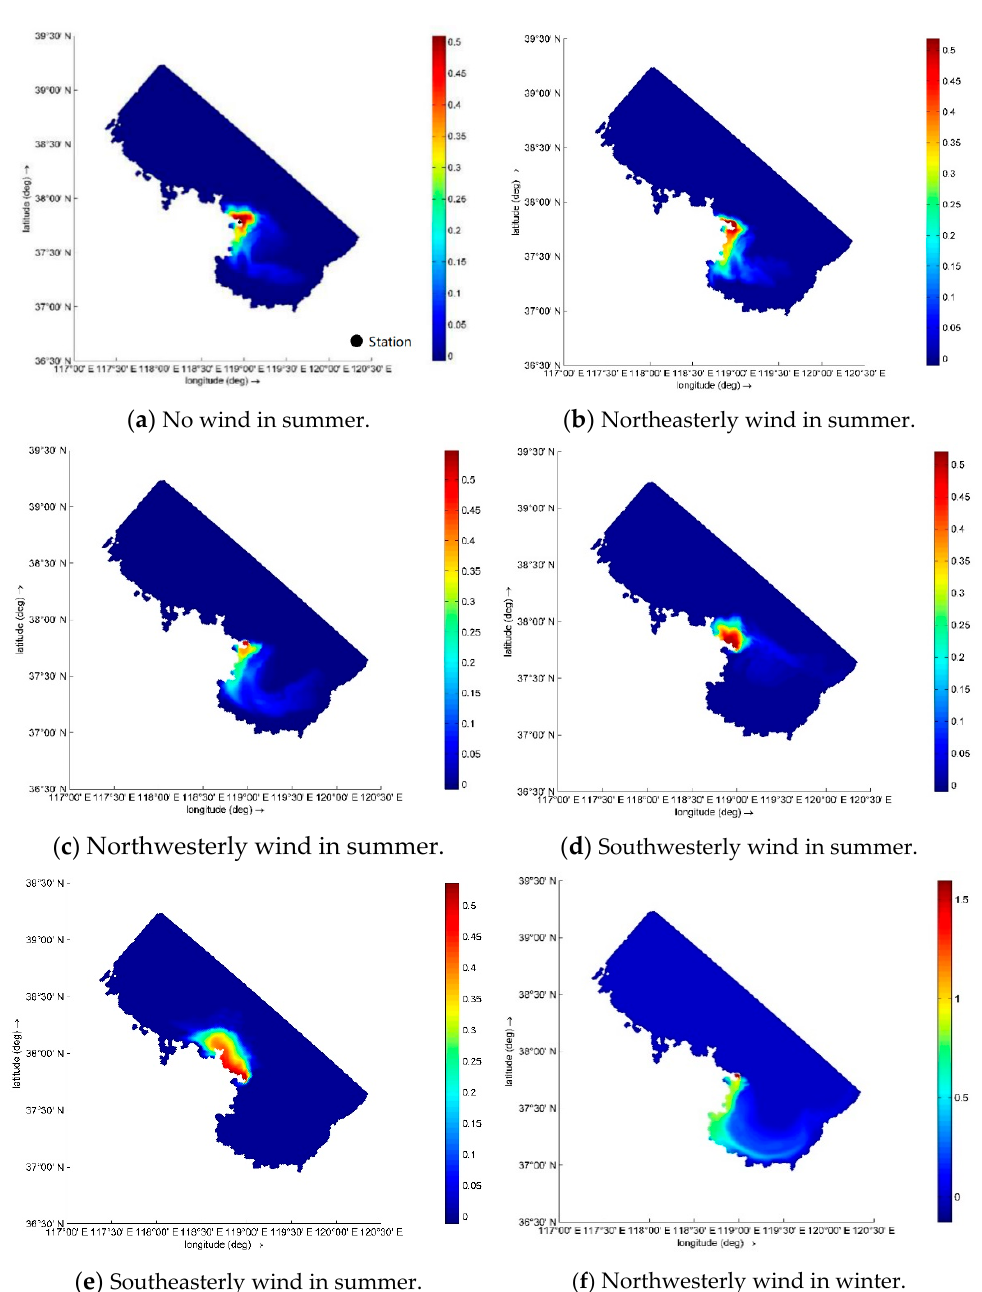
Figure 7. Suspended sediment transport at the Yellow River Delta under no wind ( a ), northeast wind ( b ), northwest wind ( c ), southwest wind ( d ), southeast wind ( e ) in summer and northwest wind ( f ) in winter (Unit: g/L) [30].